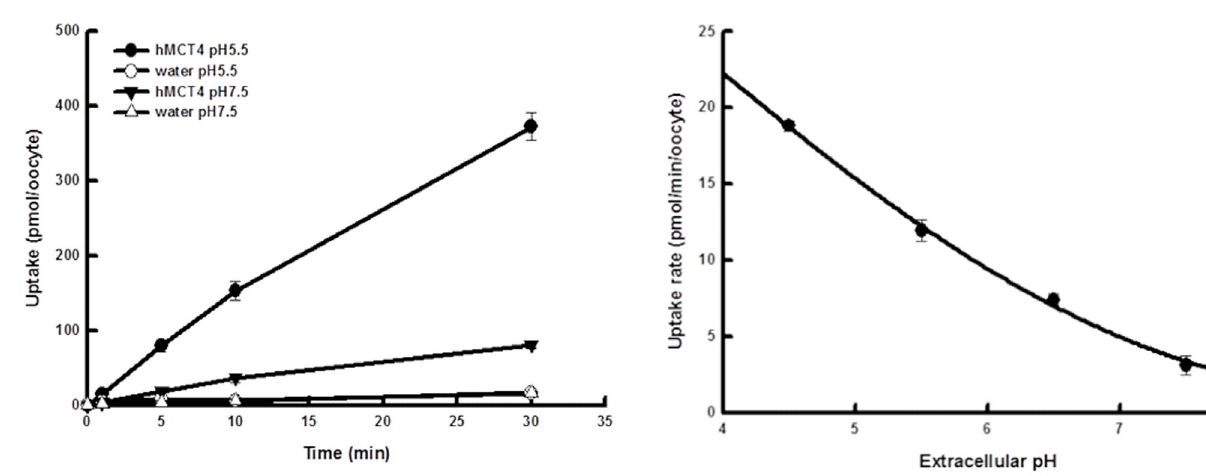
Figure 3. pH-dependency of hMCT4 activity in the presence of L-lactate. Uptake by oocytes was assayed for 10 min at 25 u C in the presence of 0.1 mM L-lactate. Each point represents the mean 6 S.E. of three – five experiments. The background uptake values of water- injected oocytes were subtracted.